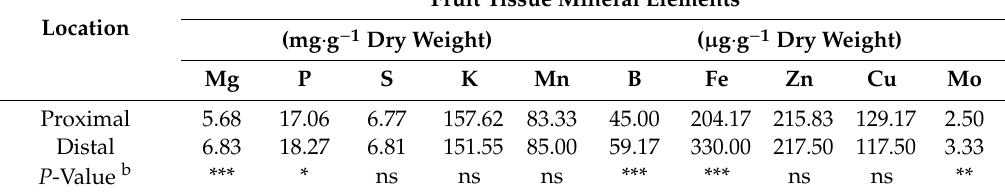
Table 4. Mineral nutrients in fruit tissue of ‘Mt. Fresh Plus’ tomato plants grown in a greenhouse and treated with exogenous applications of abscisic acid (ABA). Fruit tissue was harvested at 84 d after seeding from the second cluster at the red ripe stage for each treatment and replication for mineral nutrient analysis.